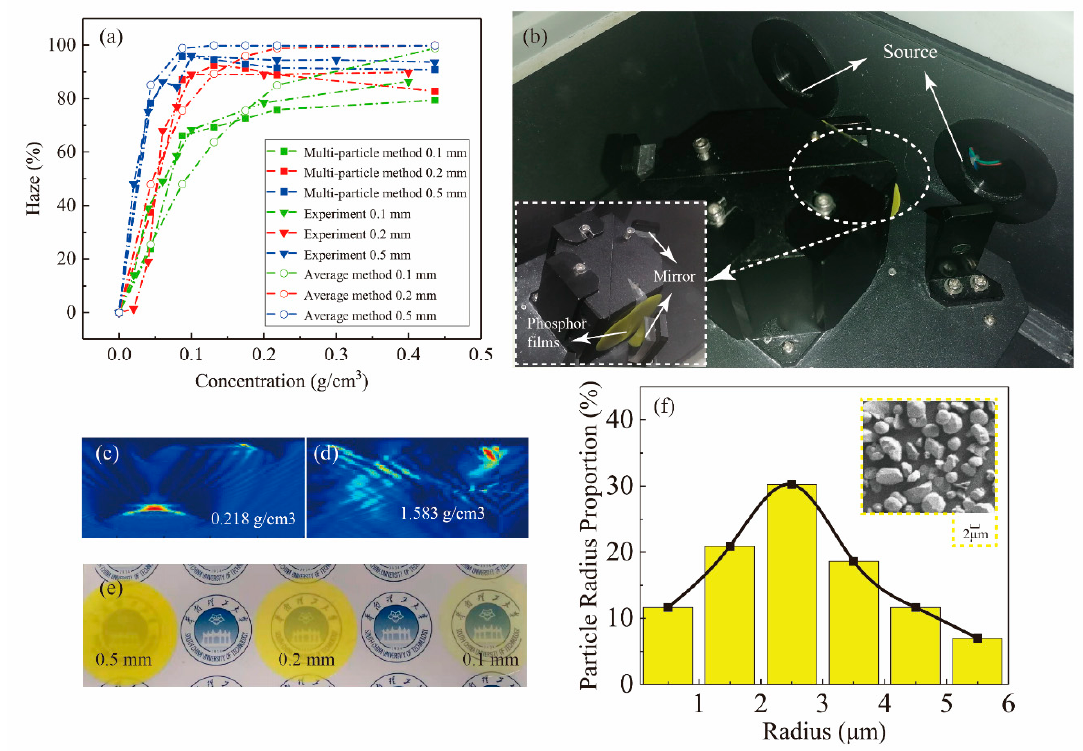
Figure 10. ( a ) Comparison of multi-particle method simulated and experimental results for the haze. ( b ) Equipment used in this experiment. ( c ) Re-scattering and re-absorption when the concentration is 0.218 g/cm 3 . ( d ) Re-scattering and re-absorption when the concentration is 1.583 g/cm 3 . ( e ) Comparison of 0.1 g/cm 3 phosphor films when the thickness is 0.1, 0.2, and 0.5 mm. ( f ) The radius distribution for the phosphor particles.